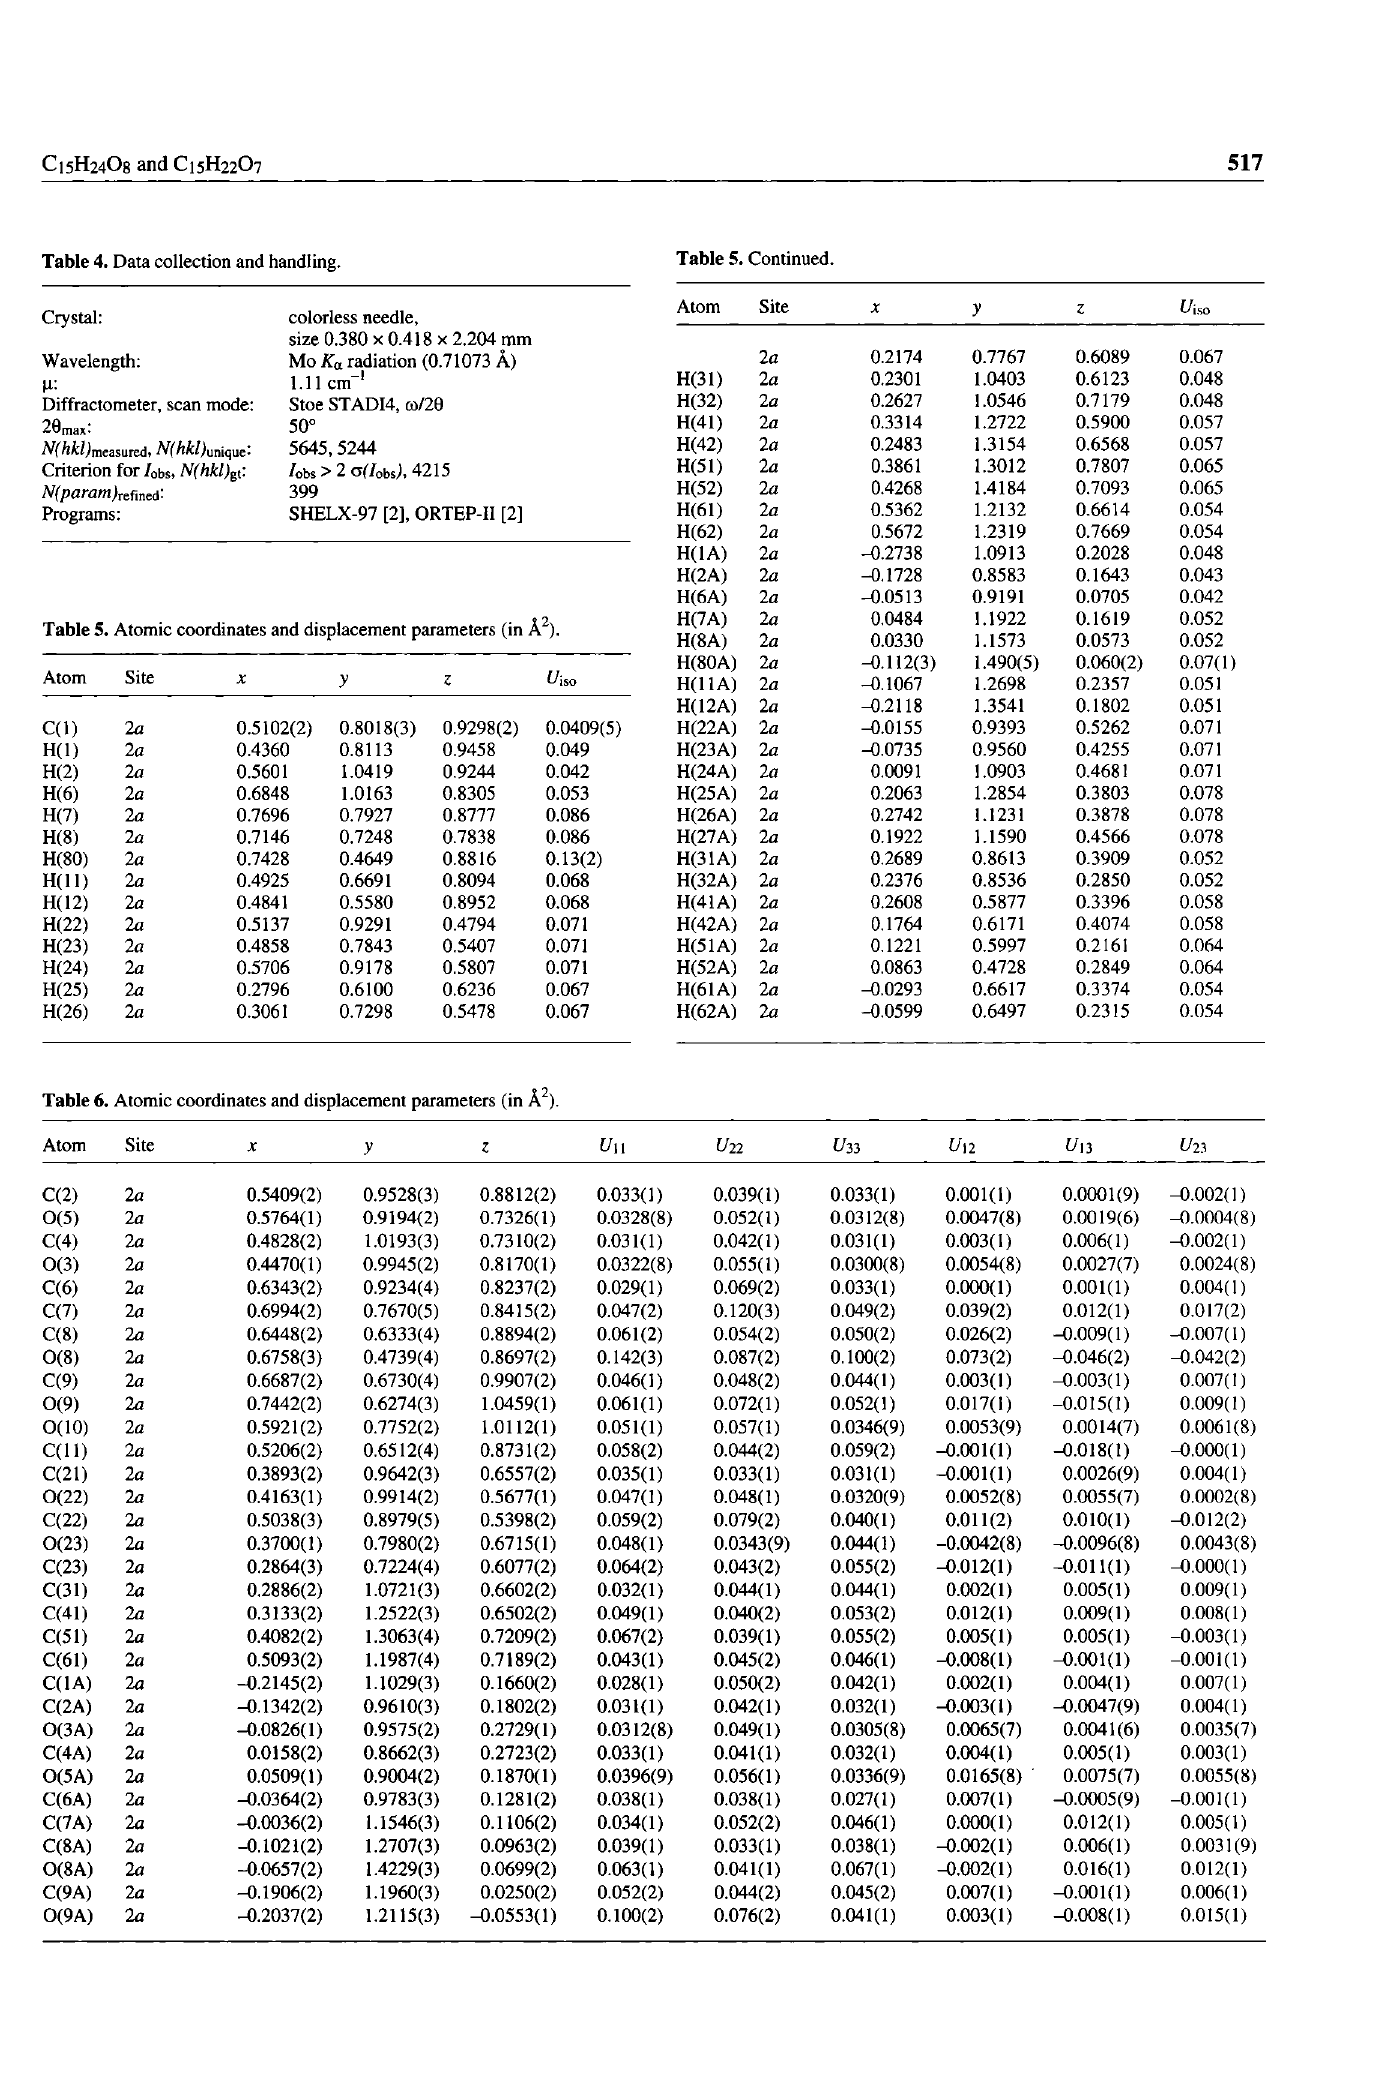
Table 6. Atomic coordinates and displacement parameters (in Â 2